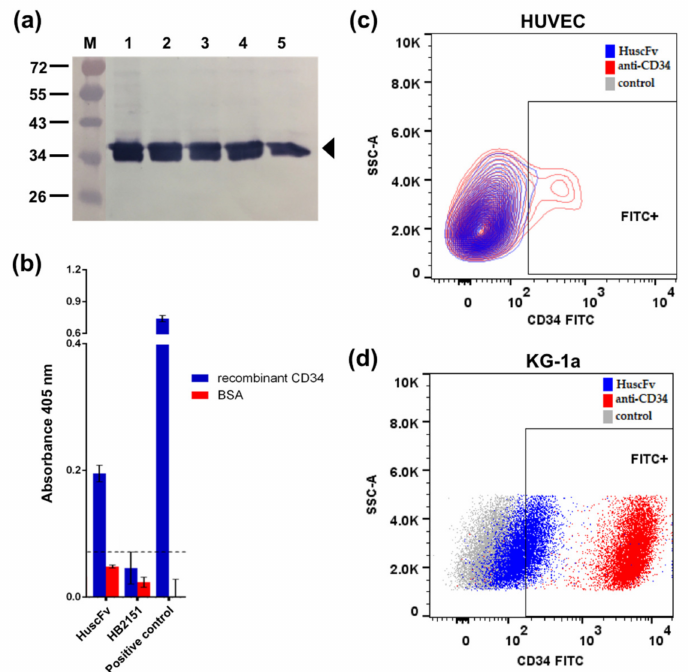
Figure 1. Characterization and binding tests of soluble anti-CD34 HuscFv. ( a ) The HuscFv (arrow- head) produced by the huscfv -positive Rosetta E. coli clone as determined by Western blotting. Lane M, Pre-stained standard protein marker; Lanes 1–5, HuscFv of randomly picked transformed E. coli colonies. ( b ) Binding test of crude HuscFv from selected phage-transformed HB2151 E. coli clone to recombinant CD34 by indirect ELISA. BSA served as negative control antigen. HB2151, lysate of original HB2151 E . coli as background binding control; Positive control, mouse anti-CD34 Ab; Dotted blackline, the cut-off absorbance between positive and negative ELISA that determined from the highest absorbance of HB2151 E. coli control. Presented data are mean ± SD ( n = 3). Representative of binding results of purified HuscFv to ( c ) HUVECs and ( d ) KG-1a cells by flow cytometry